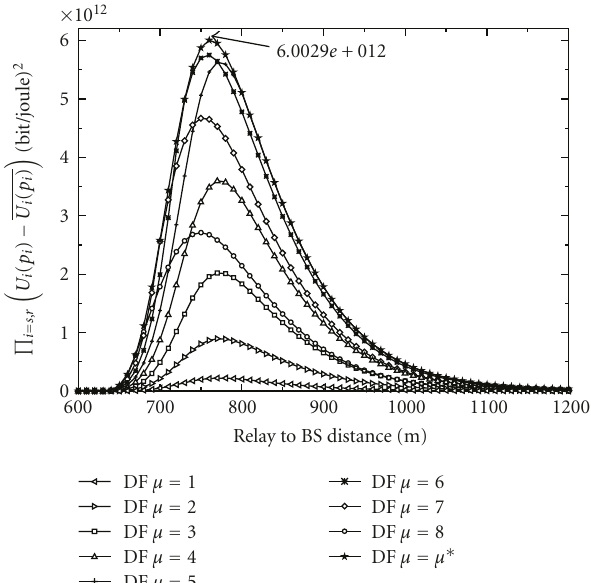
Figure 6: Value of ( U s ( p s ) − U s ( p s ))( U r ( p r ) − U r ( p r )) versus di ff erent locations of the relay under DF forwarding.